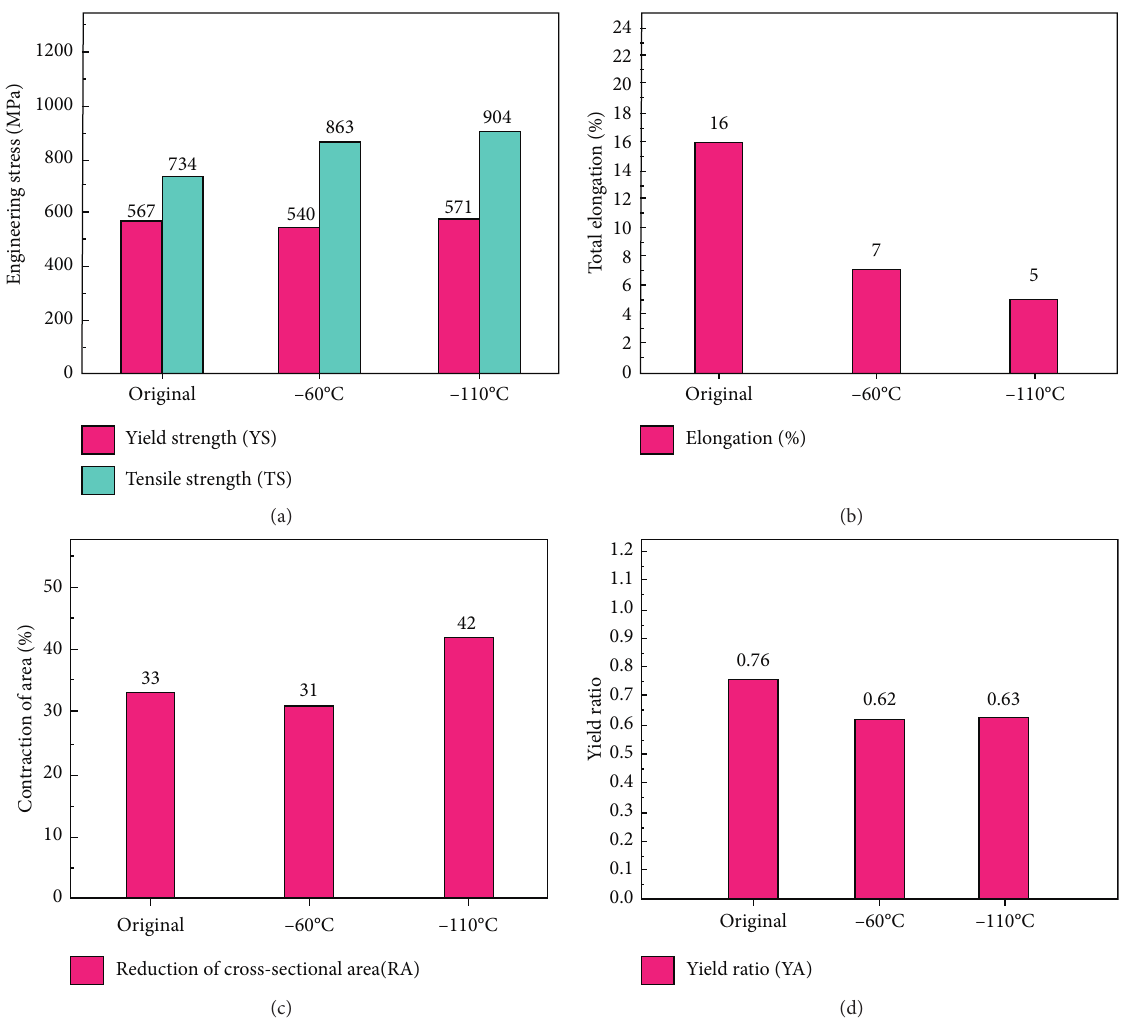
Figure 4: Mechanical properties under different processes. (a) Tensile strength and yield strength, (b) total elongation, (c) contraction of area, and (d) yield ratio.